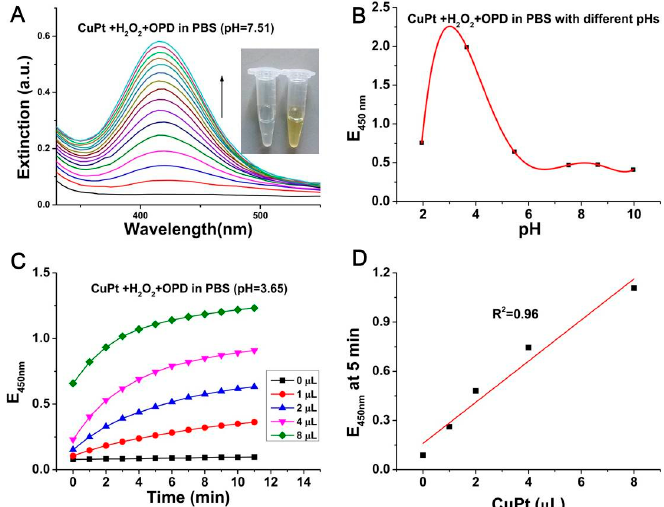
Figure 2. Peroxidase (POD)-like activity of CuPt in phosphate buffer saline (PBS). ( A ) Ultraviolet-visible-near infrared (UV-Vis-NIR) spectra of 1 μ L CuPt with o-phenylenediamine (OPD) and H 2 O 2 in PBS (pH = 7.51) for every 2 min. The insert shows the photograph of corresponding systems in the absence (left) and presence (right) of CuPt. ( B ) Effect of pH on POD-like activity of 1 μ L CuPt in PBS with different pH. ( C ) Effect of CuPt concentration in PBS (pH 3.65). ( D ) The concentration-dependent absorbance changes after incubation for 5 min in PBS (pH 3.65). The solutions contain 4.60 mM OPD and 0.50 M H 2 O 2 for ( A ), ( B ), ( C ) and ( D ).